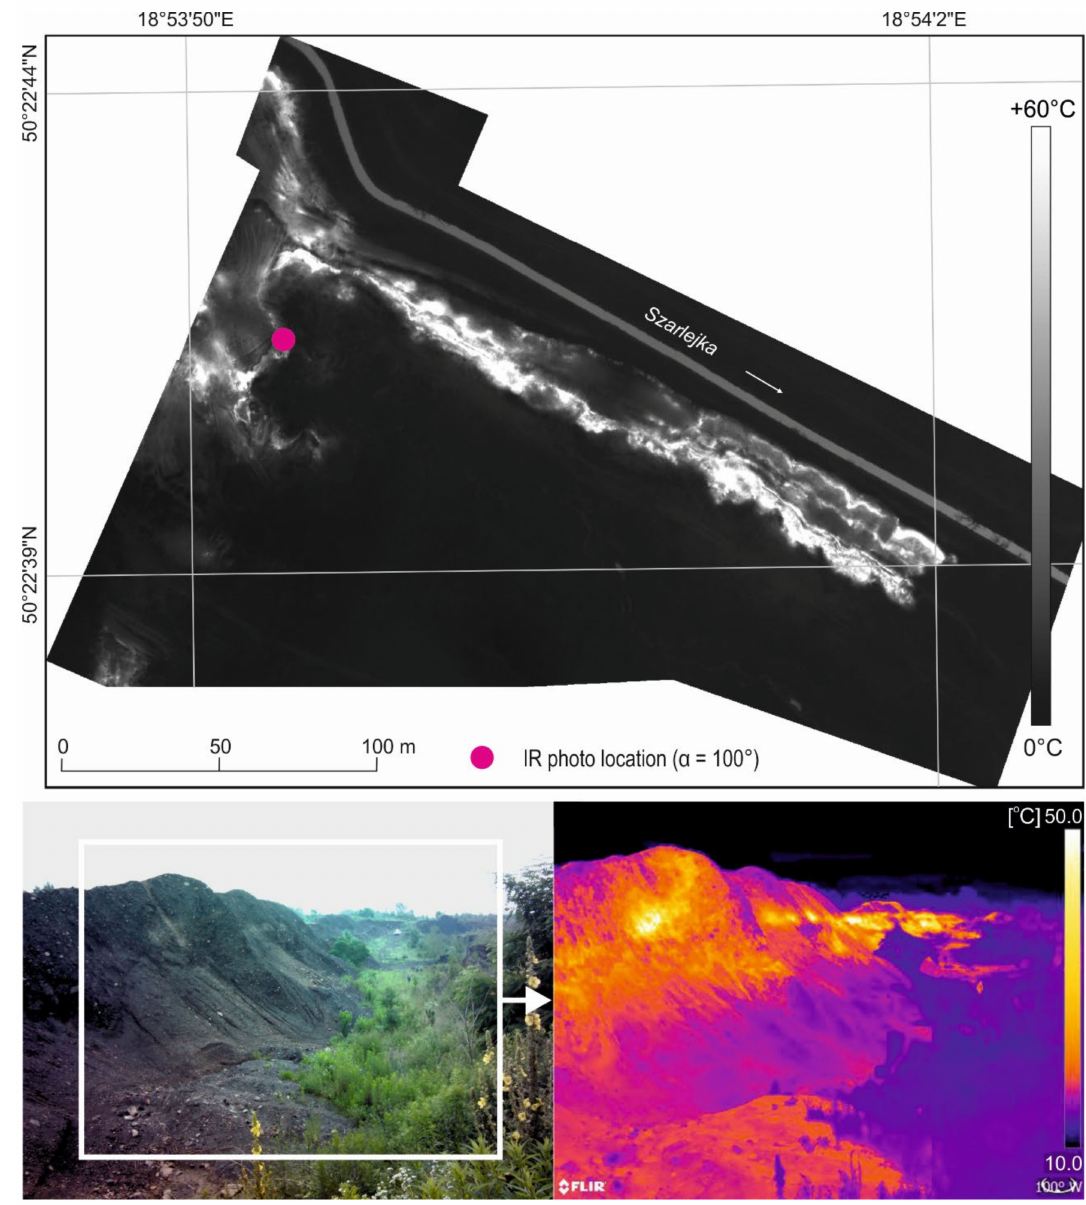
Figure 5. Thermal map (29 March 2019) and infrared photo (9 July 2020) of the coal-waste dump D-B-2.